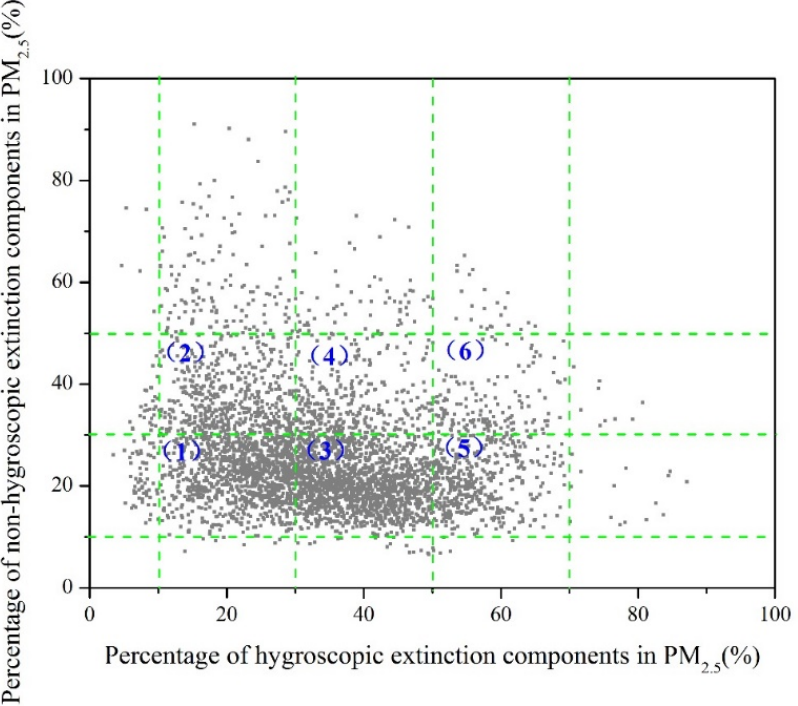
Figure 7. The percentages of hygroscopic and non-hygroscopic extinction components in PM 2.5 in Tianjin, 2015 (the numbers in brackets represent the area serial numbers for different aerosol types).